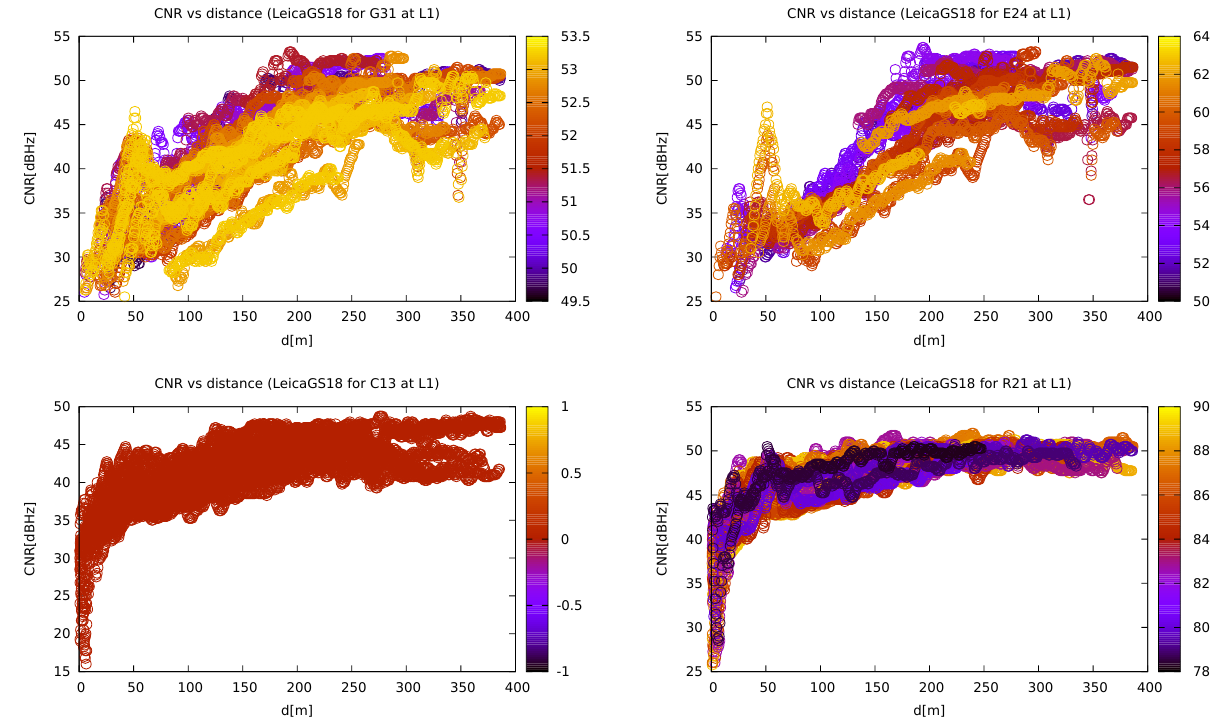
Figure 14. Carrier-to-noise ratio (CNR) of different GNSS satellites at similar elevations depending on the distance from the jammer for Leica GS18T. Note that the elevation for the BeiDou satellites was not reported correctly. Different colours represent different elevations (own study, from the collection [43]).